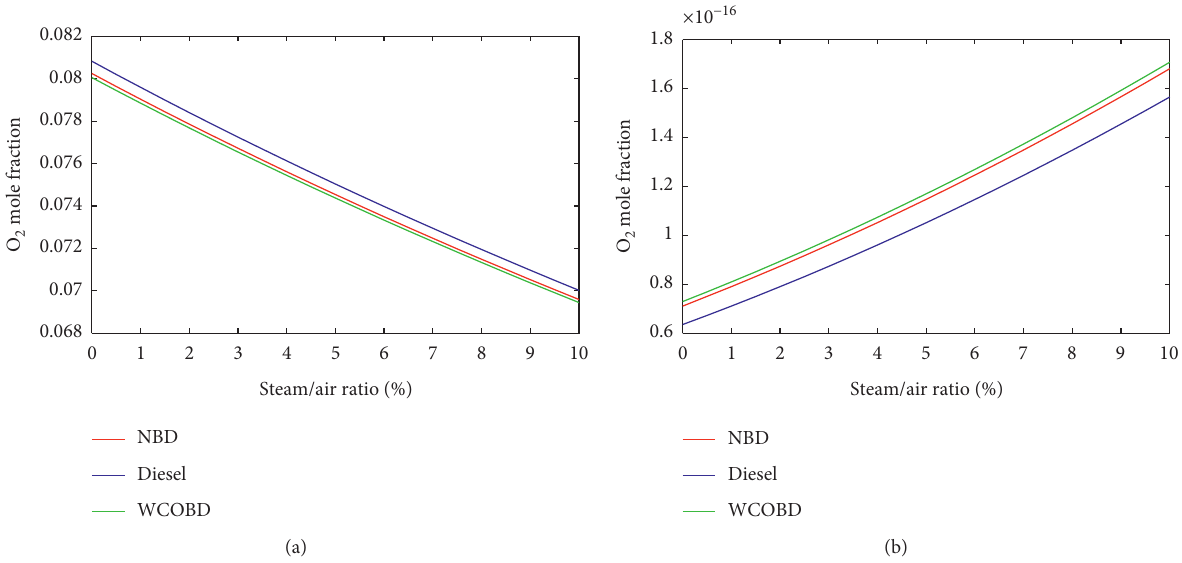
Figure 4: Variation of O 2 equilibrium mole fractions with steam injection